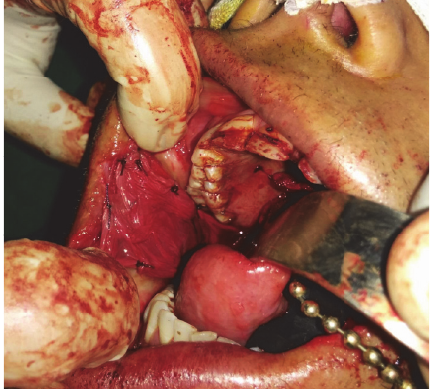
Figure 4: Collagen membrane sutured on the defect over the buccal